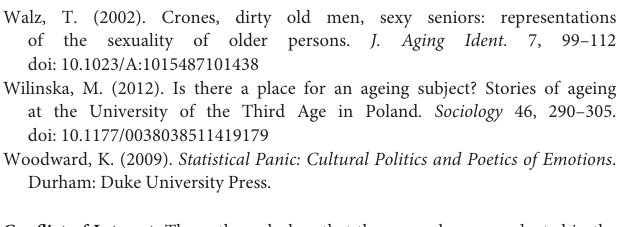
Conflict of Interest: The authors declare that the research was conducted in the absence of any commercial or financial relationships that could be construed as a potential conflict of